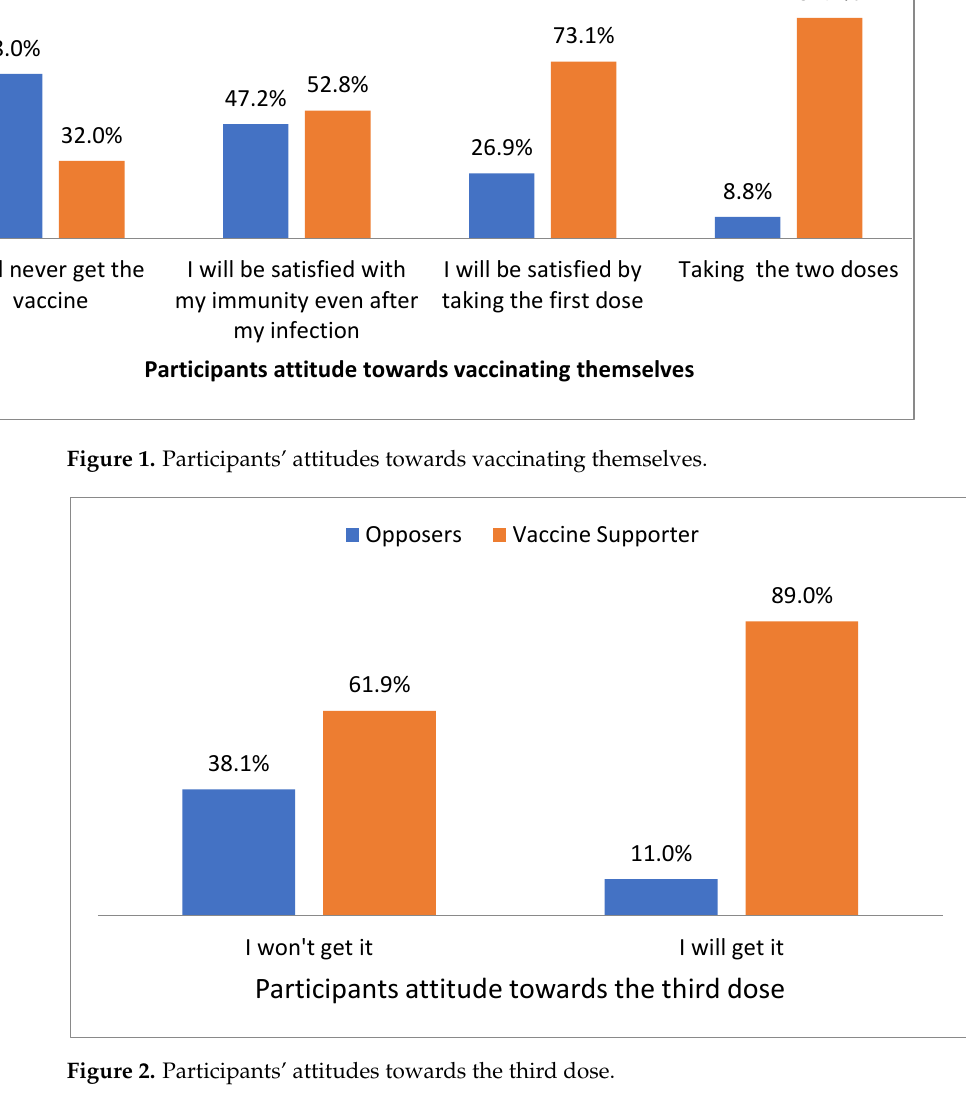
Table 5. Participants ’ attitudes, beliefs, and emotions towards COVID-19 vaccination among chil- dren.